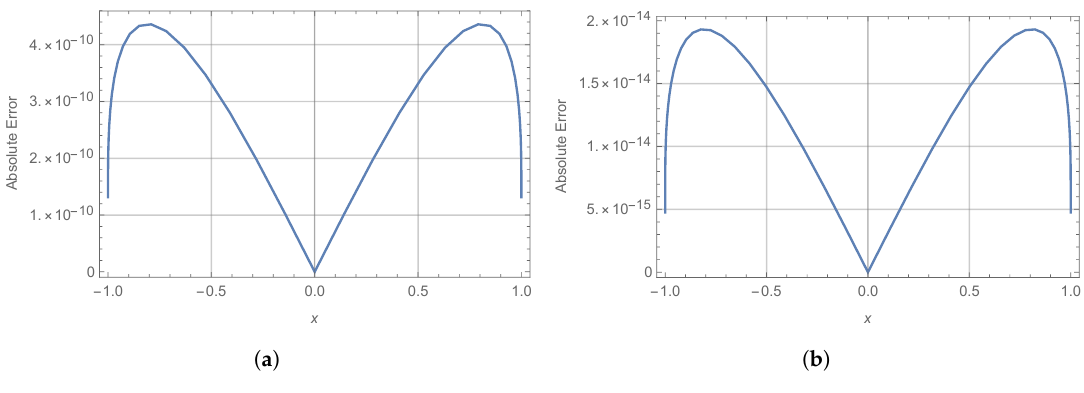
Figure 4. Plots of the absolute error of y ( x ) for Example 2 using the sinc-derivative interpolation for ( a ) N = 25 and ( b ) N =